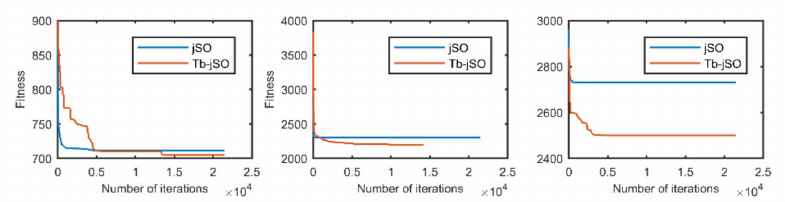
Figure 10. The selected average convergence of jSO and Tb-jSO is compared on CEC2020 in 10 D . From left to right f3, f8 and f9.